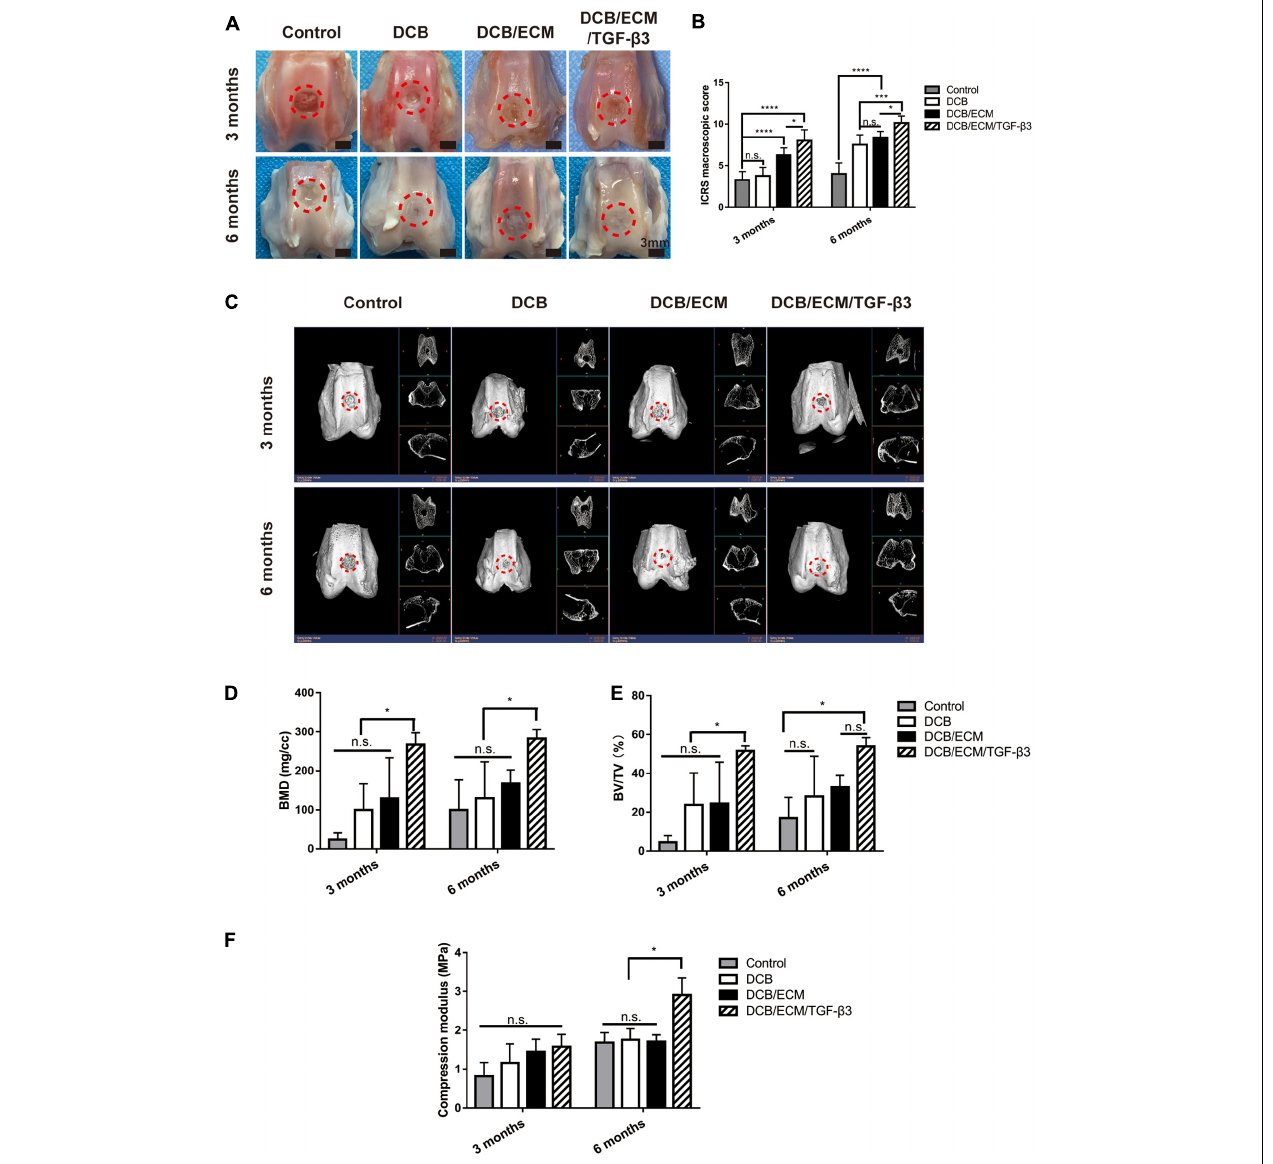
FIGURE 6 | Representative macroscopic, radiological and biomechanical properties of repaired tissues at 3 and 6 months postoperation. (A) Representative macroscopy. (B) ICRS scores at 3 and 6 months. (C) Representative 3D and 2D micro-CT images at each time point. Quantitative analysis of (D) BMD and (E) BV/TV ( n = 6 knees). The repaired sites were indicated by red circles. (F) Compression modulus of repaired tissues at 3 and 6 months ( n = 3 knees). The red circles indicate the repaired areas. Data are means ± SDs (* p < 0.05, *** p < 0.005, **** p < 0.001, n.s. represents no significant